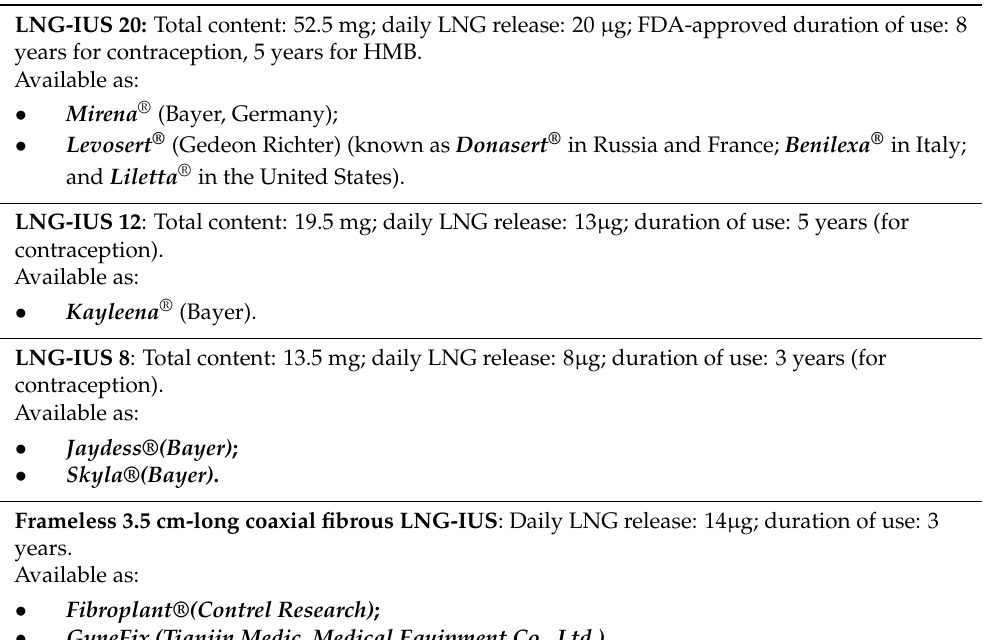
Table 1. Various types of devices available on the